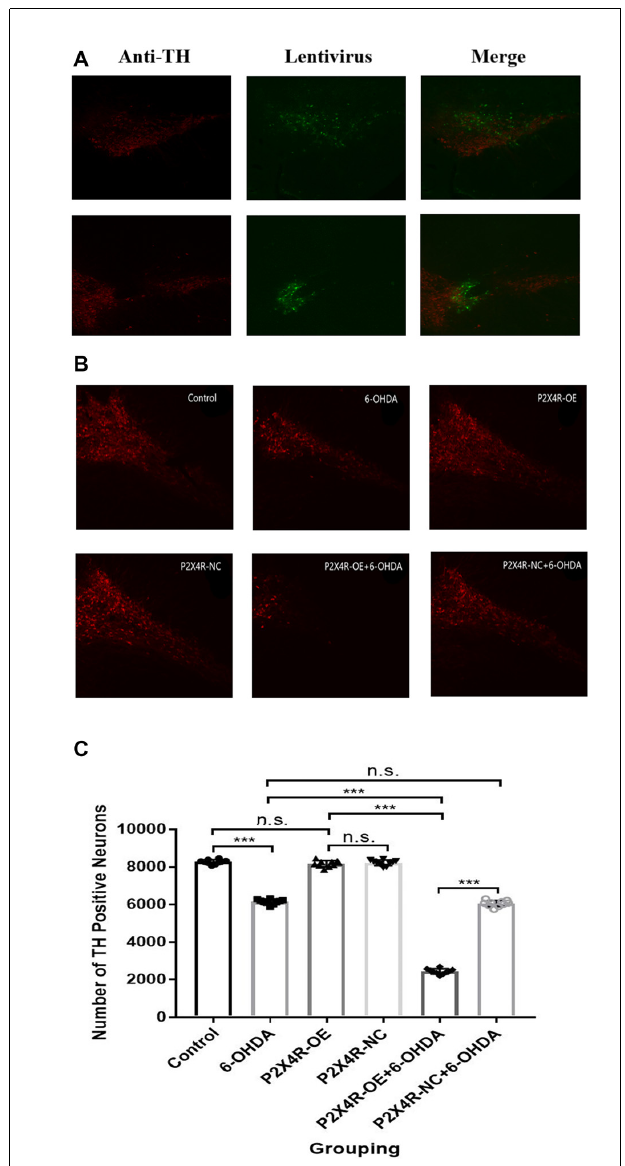
FIGURE 3 | (A) Transfection of recombinant lentivirus in tyrosine hydroxylase (TH) positive DA neurons (x100). (B) Rrepresentative immunofluorescence pictures of six groups (x100). (C) Quantification of TH positive DA neurons ( n = 10). *** P < 0.001; n.s.: there is no statistical difference between the two